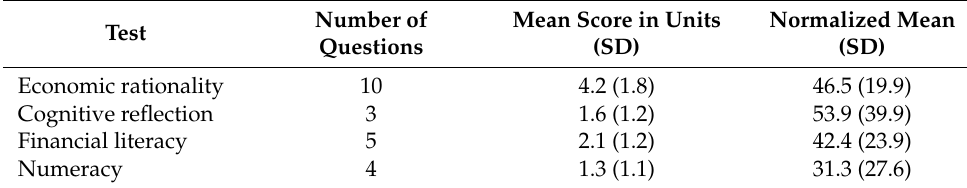
Table 4. Summary score for all tests.